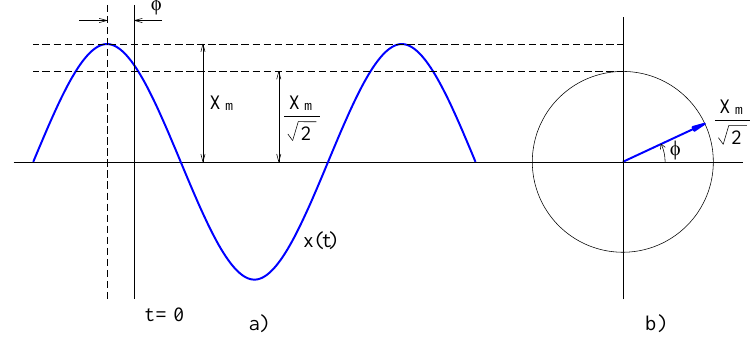
Figure 2. ( a ) sinusoidal waveform; ( b ) phasor representation.